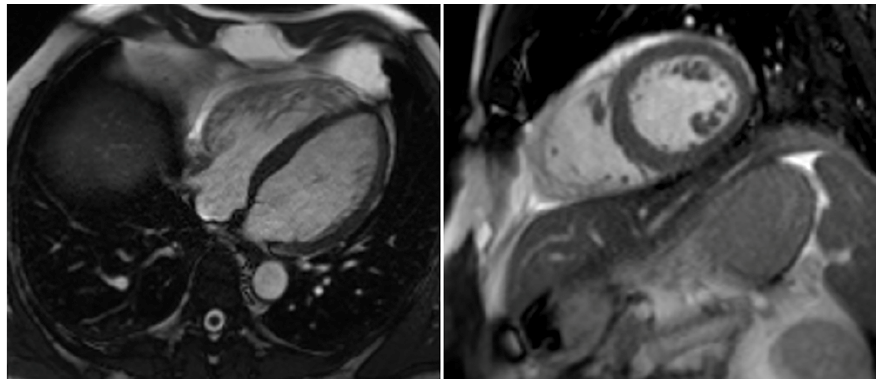
Figure 10. Four chamber view (left side) and short axis view (right side) of a cardiac magnetic resonance imaging (MRI) four weeks after the procedure. Right ventricular failure could be excluded; however, prominent trabeculation was present.